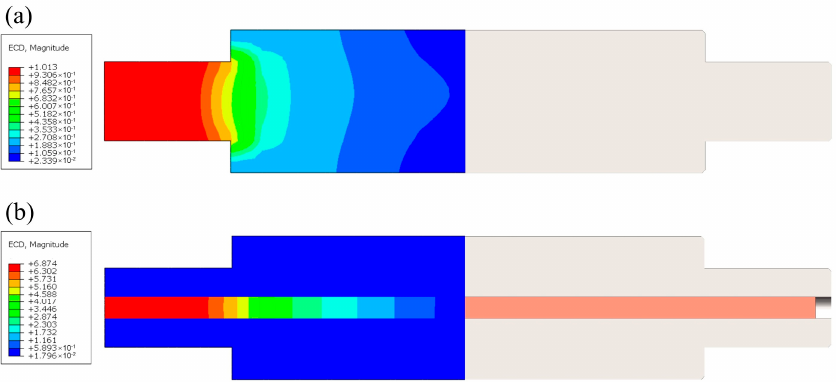
Figure 7. The current density J e of cylindrical axis electrode: ( a ) 9Cr2Mo; and ( b ) Copper + 9Cr2Mo.